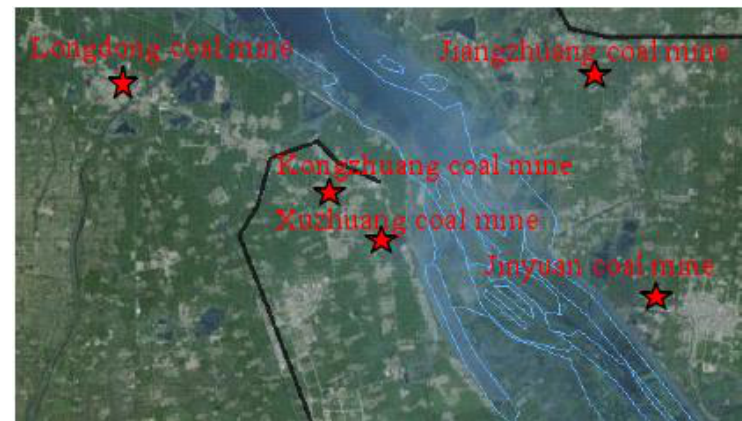
Figure 2. The study area of Peixian in